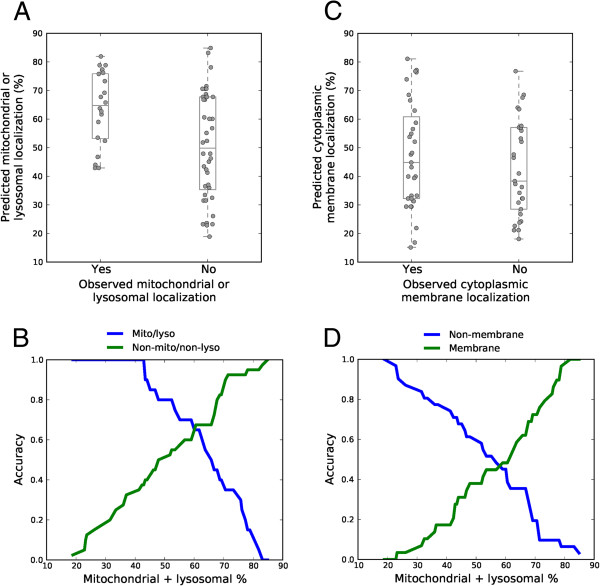
The observed staining patterns in relation to the predicted, cellular staining patterns of styryl probes. A) Plot shows the calculated, predicted percent accumulation of probes in mitochondria or lysosomes, relative to the observed staining patterns (YES means the compounds were visually scored as staining mitochondria or lysosomes; NO means the compounds were visually scored as staining cytoplasmic (or plasma) membranes, nuclei or nucleoli). B) The Accuracy of the predicted, subcellular distributions of probes to mitochondria or lysosomes relative to the observed mitochondrial or lysosomal (or nonmitochondrial and nonlysosomal) staining patterns, as shown in A), plotted as a function of the threshold % predicted mass accumulation in mitochondria or lysosomes. Each threshold % mass accumulation is used to distinguish between those probes that are predicted to localize to mitochondria or lysosomes vs. those that are not. C) Plot shows the calculated, predicted percent accumulation in cytoplasmic membranes, relative to the observed staining patterns (YES means the compounds were visually scored as staining cytoplasmic or plasma membrane; NO means the compounds were visually scored as staining mitochondria, lysosomes nuclei or nucleoli). D) The Accuracy of the predicted, subcellular localization categories of the probes in cytoplasmic (or plasma) membranes relative to the observed cytoplasmic (or plasma) membrane staining pattern vs. other observed staining patterns as shown in B), plotted as a function the threshold % predicted mass accumulation in mitochondria or lysosomes.